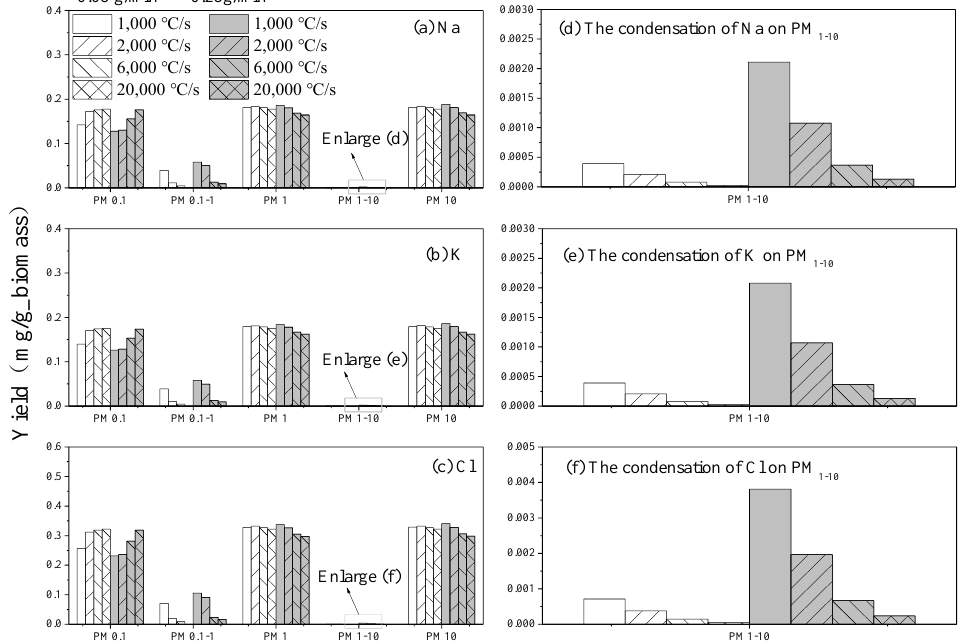
Figure 8. The yield of elements in PM 10 and the condensation amounts on PM 1–10 at different cooling rates were calculated under two biomass feeding rates. ( a – c ) are the calculated yields of elements Na, K and Cl, respectively; ( d – f ) are the condensation of elements Na, K and Cl on PM 1–10 , respec- tively.